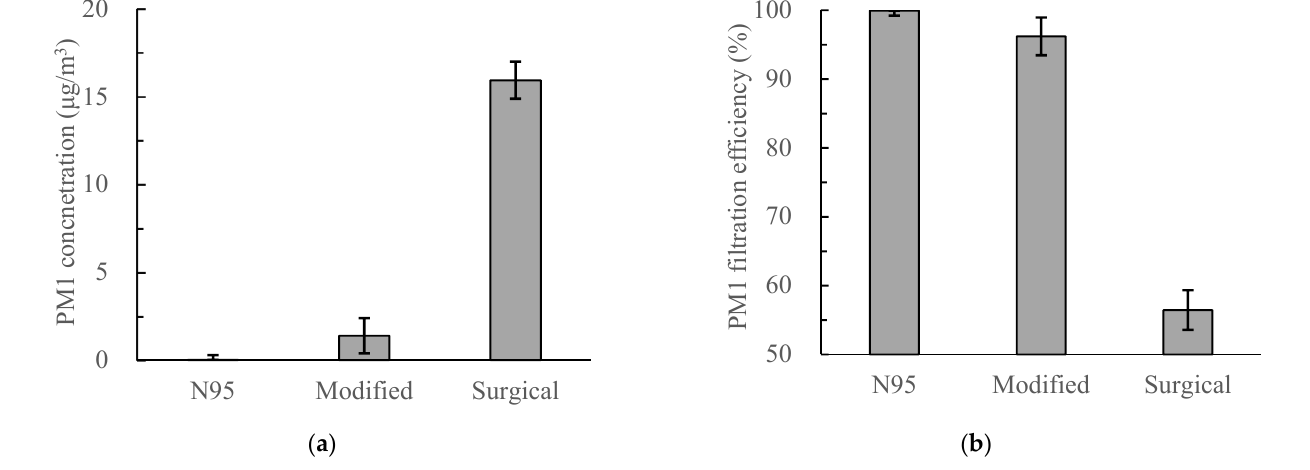
Figure 7. Comparison of the overall PM 1 filtration efficiency among three face masks, where error bars represent the standard deviation of five repetitive measurements: ( a ) measured PM 1 concentrations inside face masks (background PM 1 concentration: 36 μ g/m 3 ), ( b ) overall filtration efficiency.